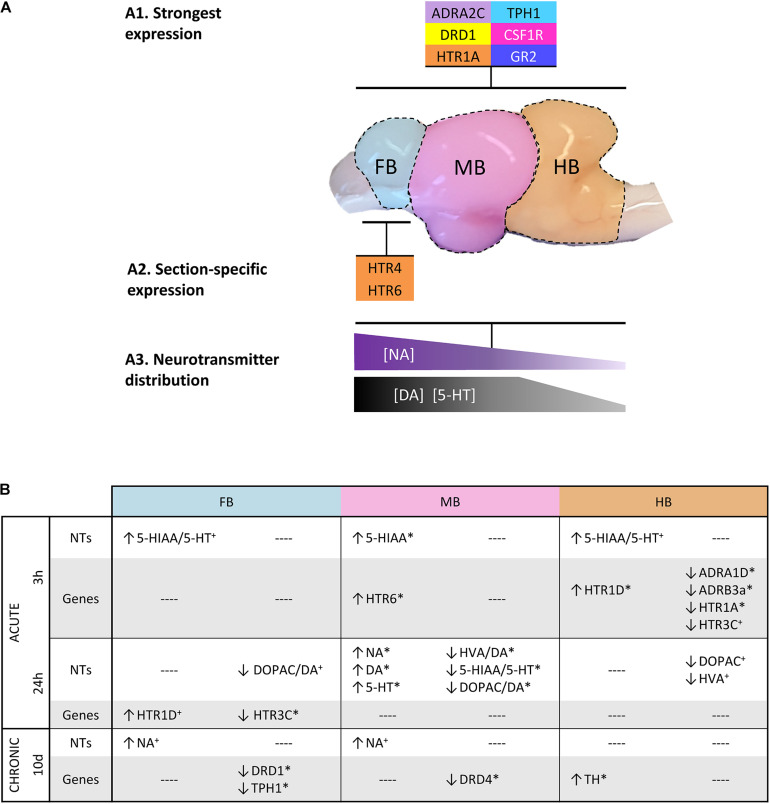
Graphical summary about (A1) the most strongly expressed genes with a similar distribution across the three brain sections; (A2) those genes that were particularly high expressed in specific sections; and (A3) the spatial distribution of specific neurotransmitters. (B) Overview of the parameters that were affected by acute and chronic handling at the different time points in the analyzed brain sections. (↑) increased or (↓) decreased ratios/concentrations in case of neurotransmitters (NT) and >2-fold up- or <–2-fold down-regulation in the case of gene expression. Statistical significance is indicated with (∗) at p < 0.05; non-significant tendency indicated as (+) at 0.05 < p < 0.10. See Figure 5 for heatmap with all target genes.